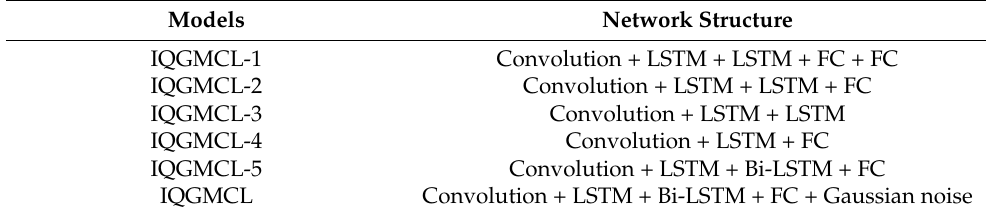
Table 2. Comparison table of network structure of each model. Models